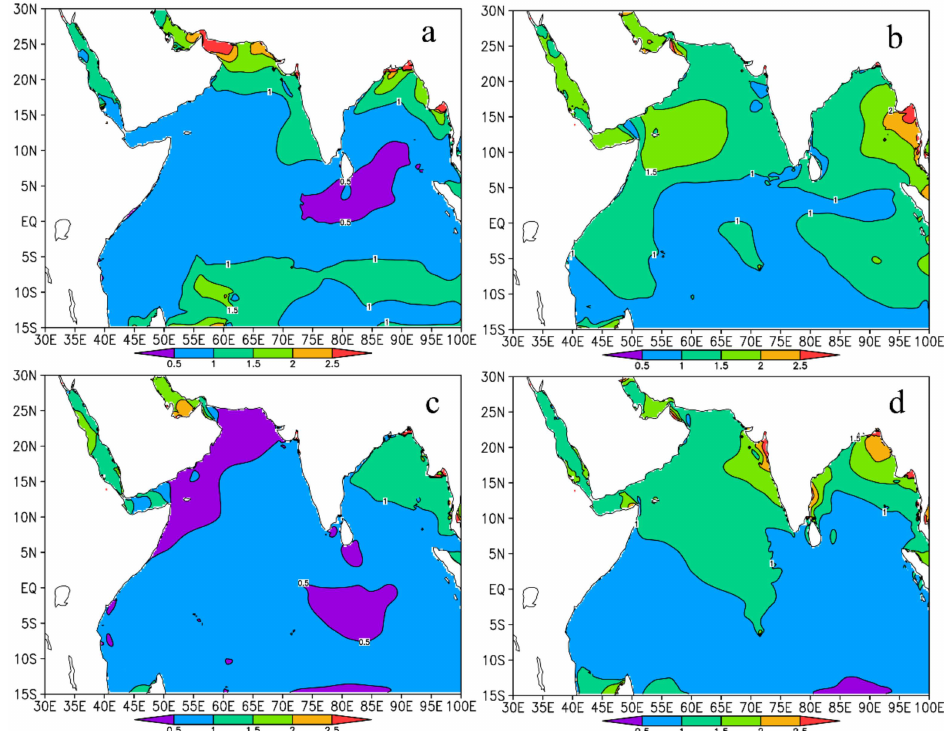
Figure 10. Coe ffi cient of variation of wave energy density in ( a ) winter, ( b ) spring, ( c ) summer, and ( d ) autumn in the